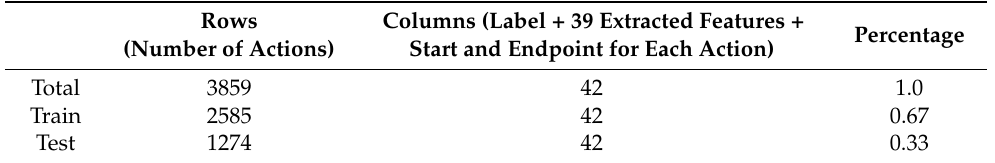
Figure 4. Screenshots for designed exams are as follows: ( a ) a screenshot of a C++ coding question; ( b ) a screenshot of a true & false question. Table 3. Distribution of dataset.